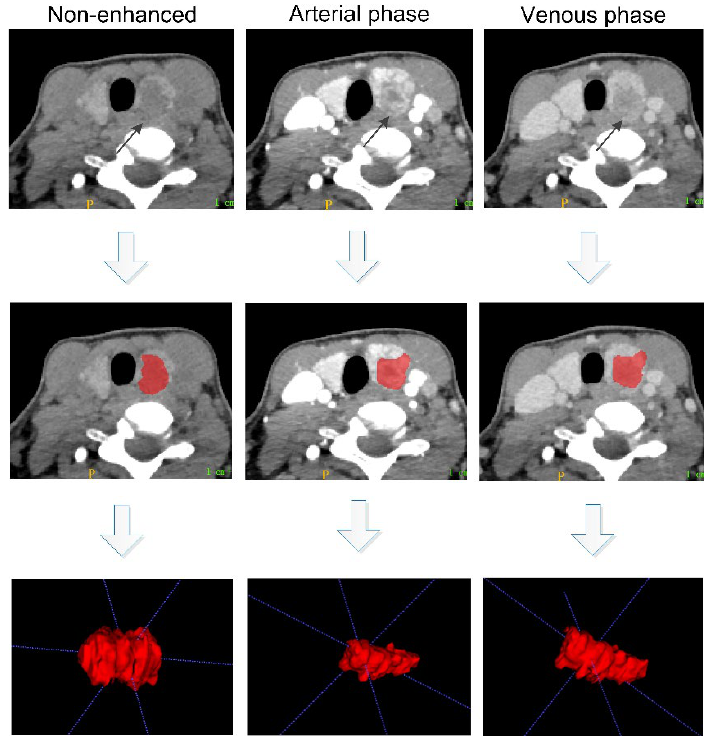
Figure 3. Segmentation of the ROIs on three-phase (nonenhanced, arterial phase and venous phase) axial CT images. Three-dimensional reconstruction was performed using the ROIs from the axial, sagittal and coronal plane images. The black arrows indicate the location of the primary lesion. Abbreviation: ROIs, regions of interest.